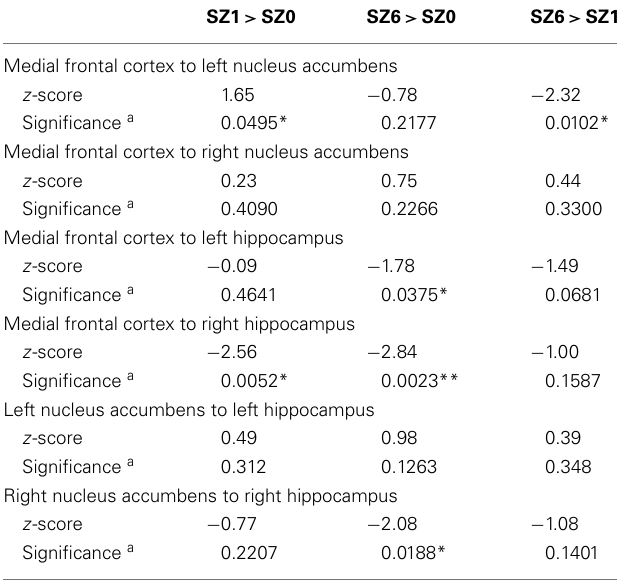
Table 10 | Changes in functional connectivity between three time points in antipsychotic drug